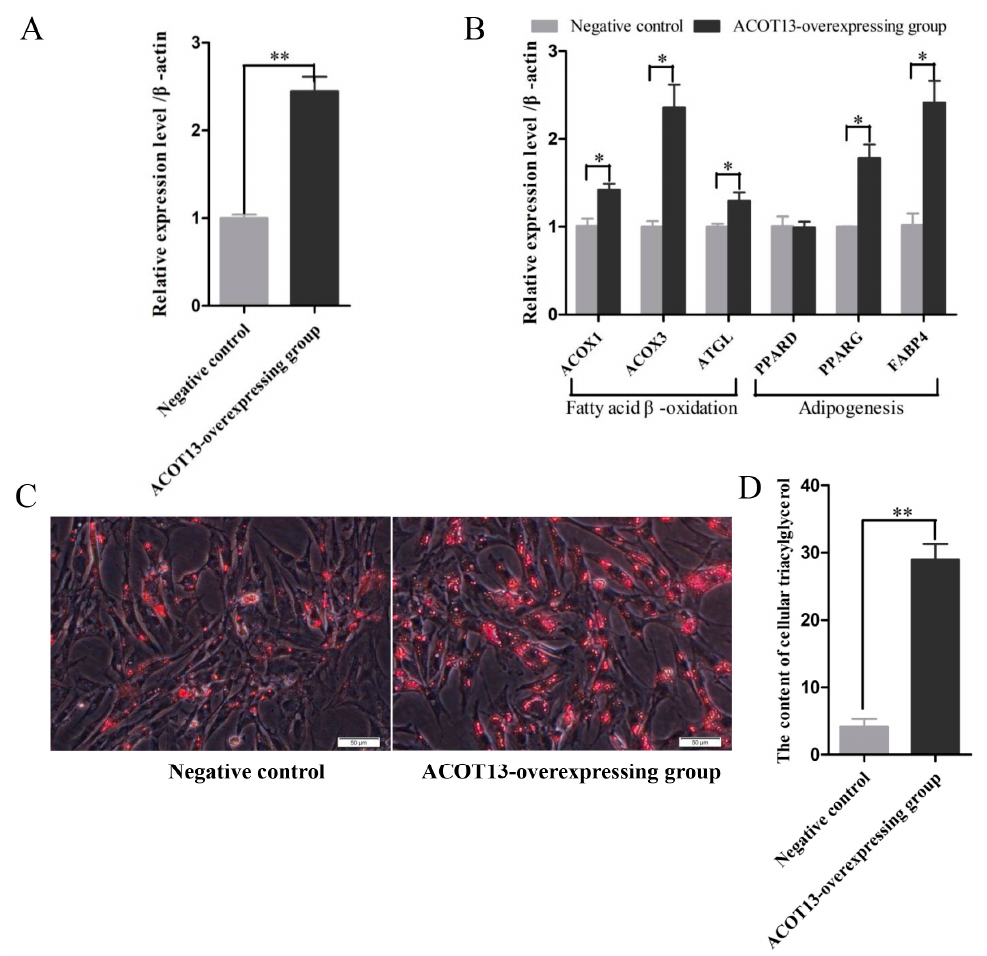
Figure 6. Overexpression of ACOT13 promoted adipocyte differentiation in intramuscular adipocytes. ( A ) ACOT13 expression level was induced in the ACOT13 overexpressing group. ( B ) Levels of ACOX1 , ACOX3 , ATGL , PPARG, and FABP4 mRNAs increased after ACOT13 overexpression. ( C ) Overexpression of the ACOT13 gene increased the lipid droplet formation in intramuscular adipocytes by Oil Red O staining. ( D ) In the ACOT13 overexpressing group, triacylglycerol synthesis was increased. * p < 0.05; ** p < 0.01.